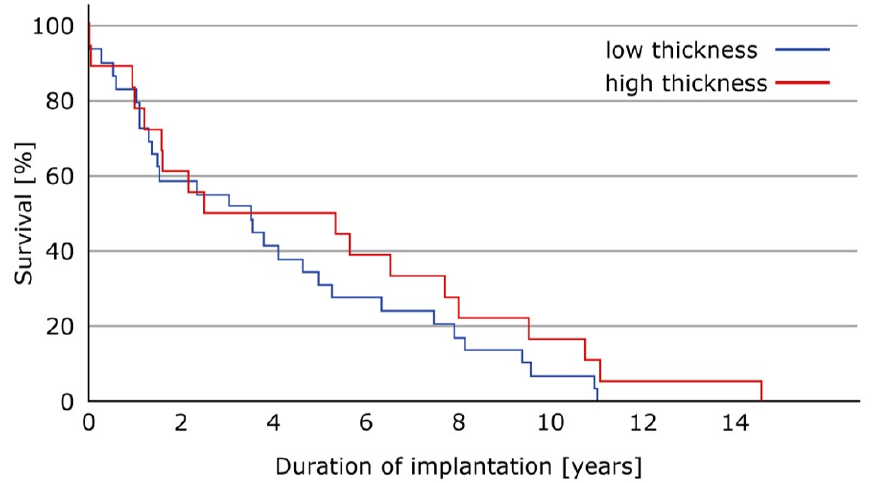
Figure 9. Kaplan-Meier blot for the two groups, showing no significant differences in survival (p = 0.264).